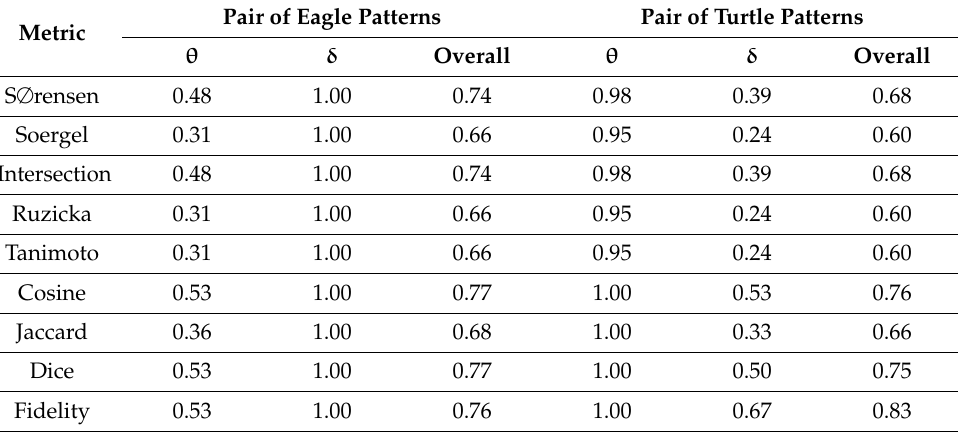
Figure 9. PDFs of angle from the centroid to each point ( θ ) for each pair of hypothetical patterns shown in Figure 5: ( a , b ) the pair of eagle patterns and ( c , d ) the pair of turtle patterns. Table 2. Spatial pattern similarity between two pairs of hypothetical patterns (shown in Figure 5), measured using nine metrics (as listed in Table 1), in terms of the geometric features used in this study (i.e., angle, θ , and distance, δ , from the centroid of the extent to each point). The overall similarity was calculated as the average of similarity of θ and similarity of δ